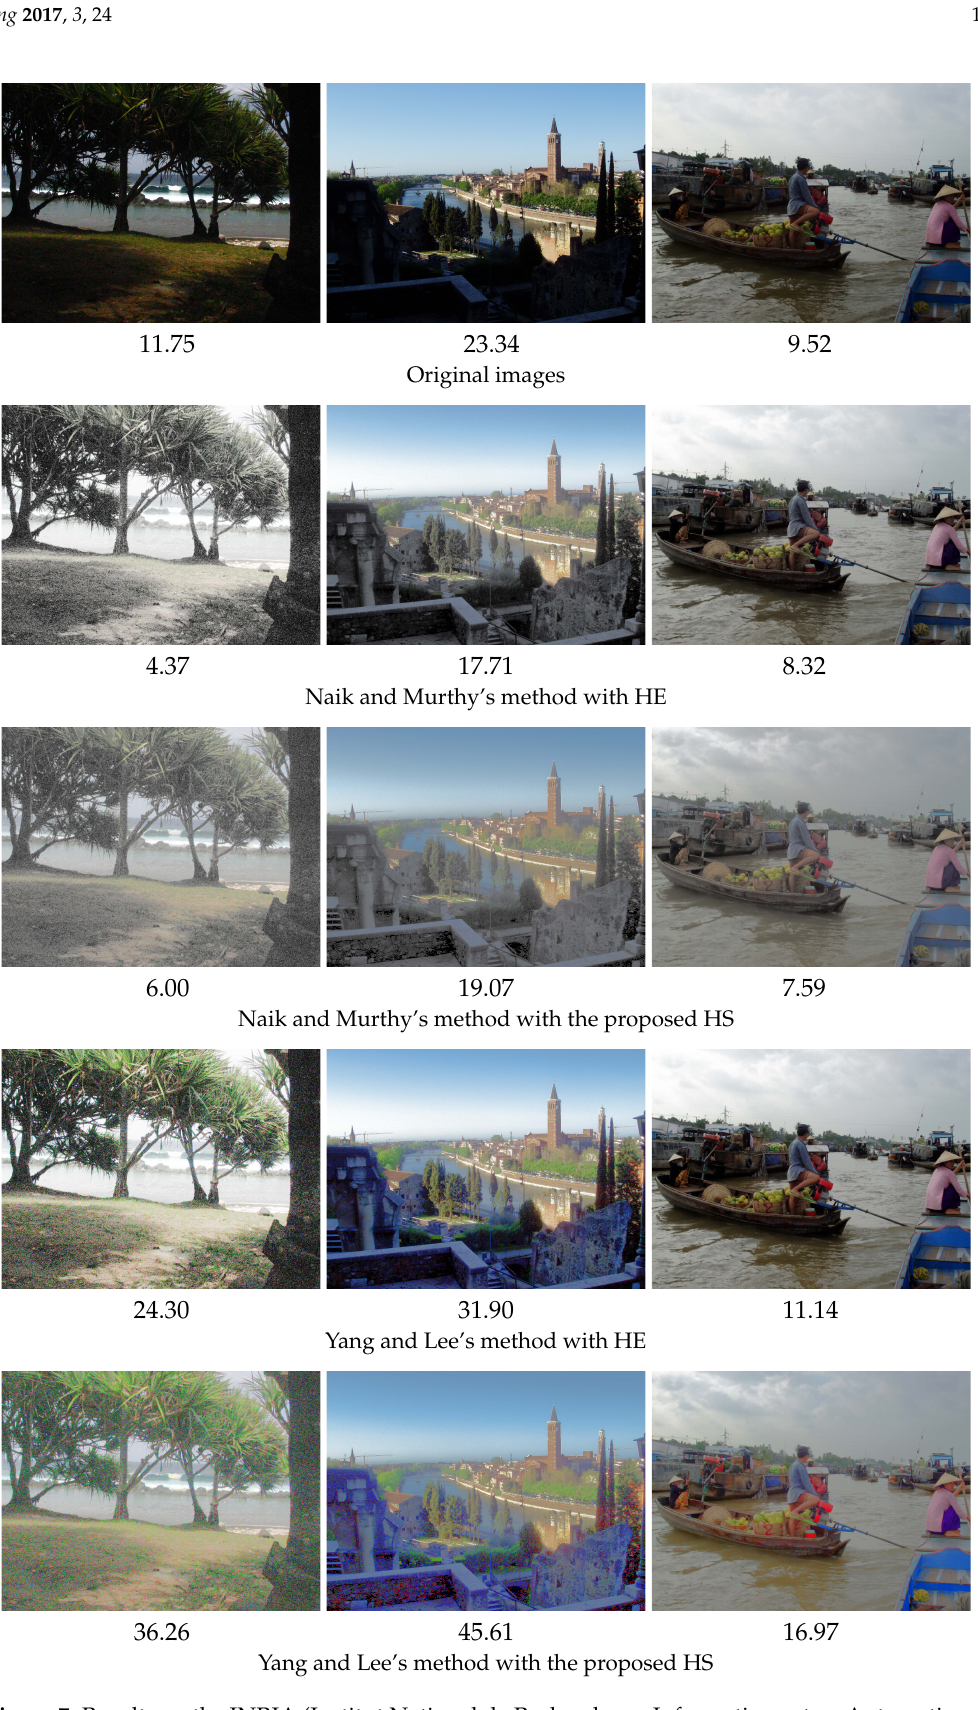
Figure 7. Results on the INRIA (Institut National de Recherche en Informatique et en Automatique) dataset with the mean saturation